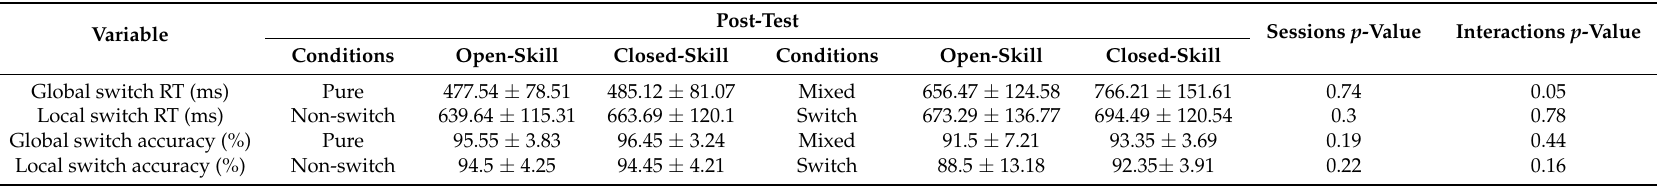
Table 3. Summary of analyses from two-way ANOVA (Exercise session × Condition) in post-test (mean value ± standard